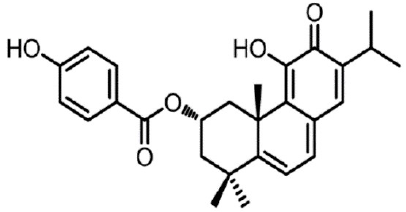
Figure 1. Molecular structure form Parvifloron D.